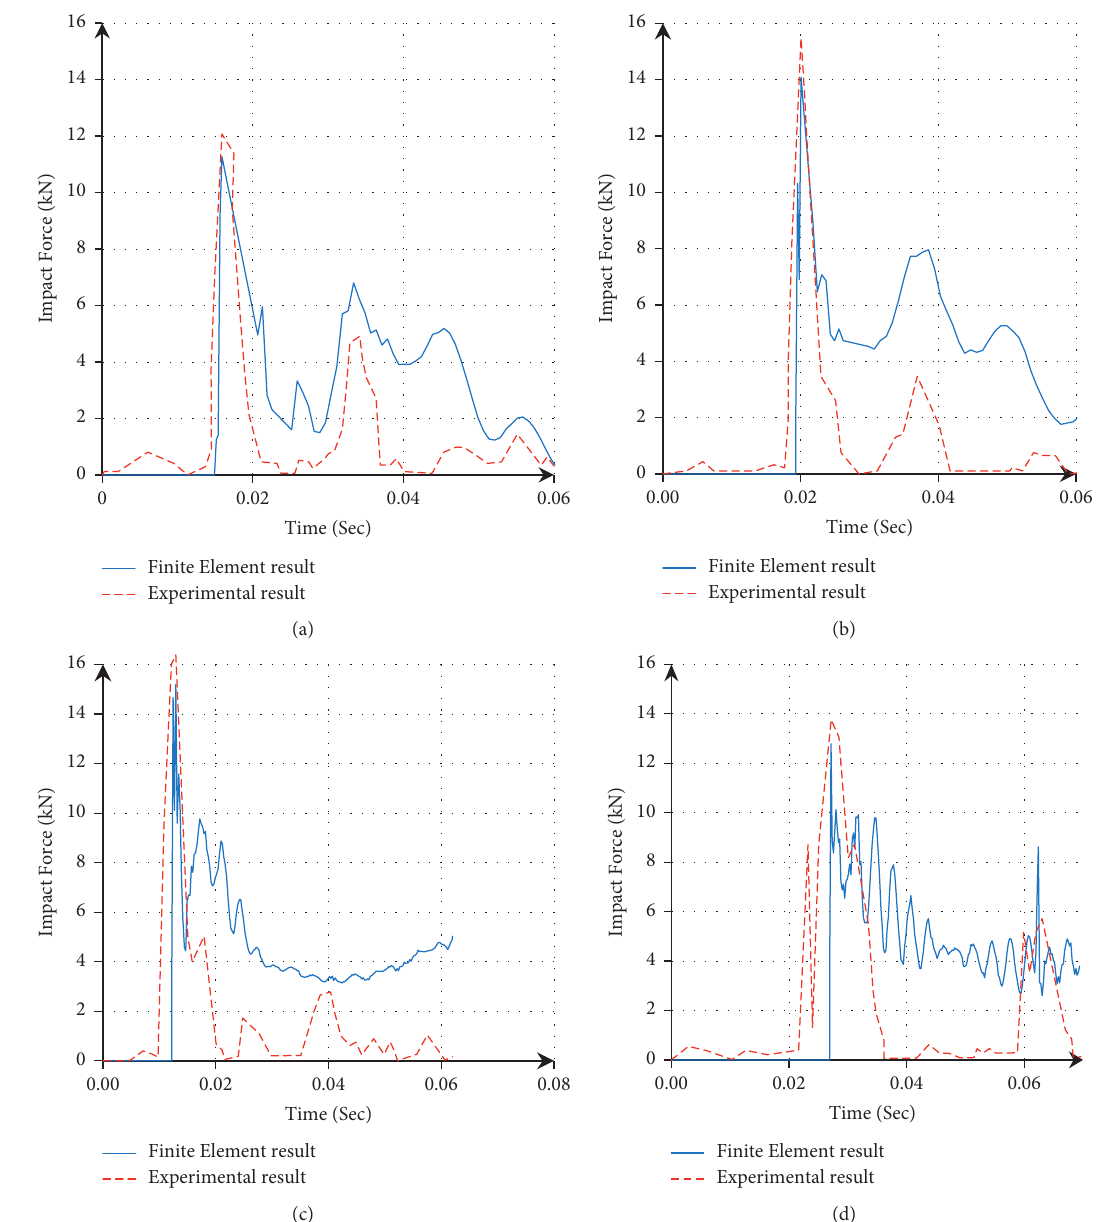
Figure 10: Impact force profile comparisons of experimental and FE analysis results under repeated impact load. (a) First impact. (b) Second impact. (c) Third impact. (d) Fourth